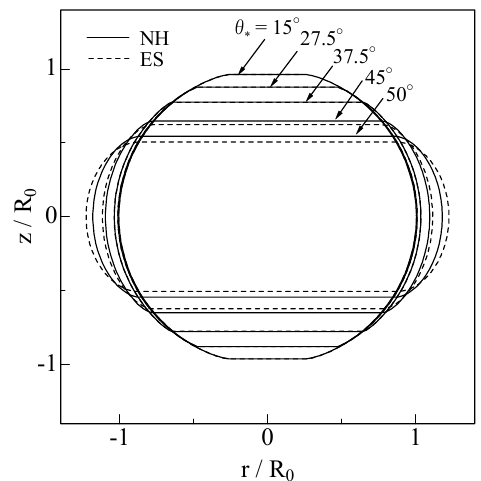
Fig.7 Shapes of the deformed microcapsules for the NH and ES materials